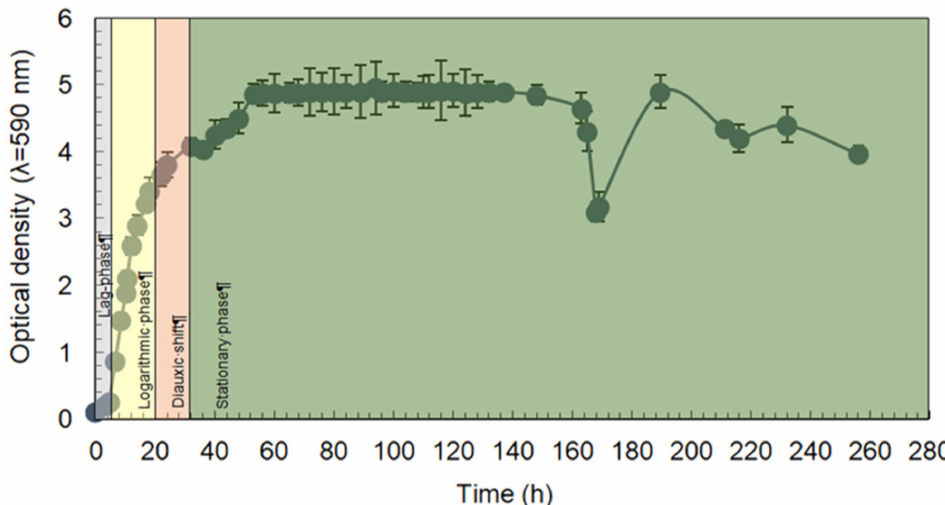
Figure 1. The growth curve of E. magnusii yeast in glycerol-containing medium grown for 260 h. Ab- sorbance was assayed every two hours in cell suspension at the wavelength of 590 nm. The curve is representative of four biological experiments. (The figure was partially used in the article [Microorgan- isms 2020, 8, 91;